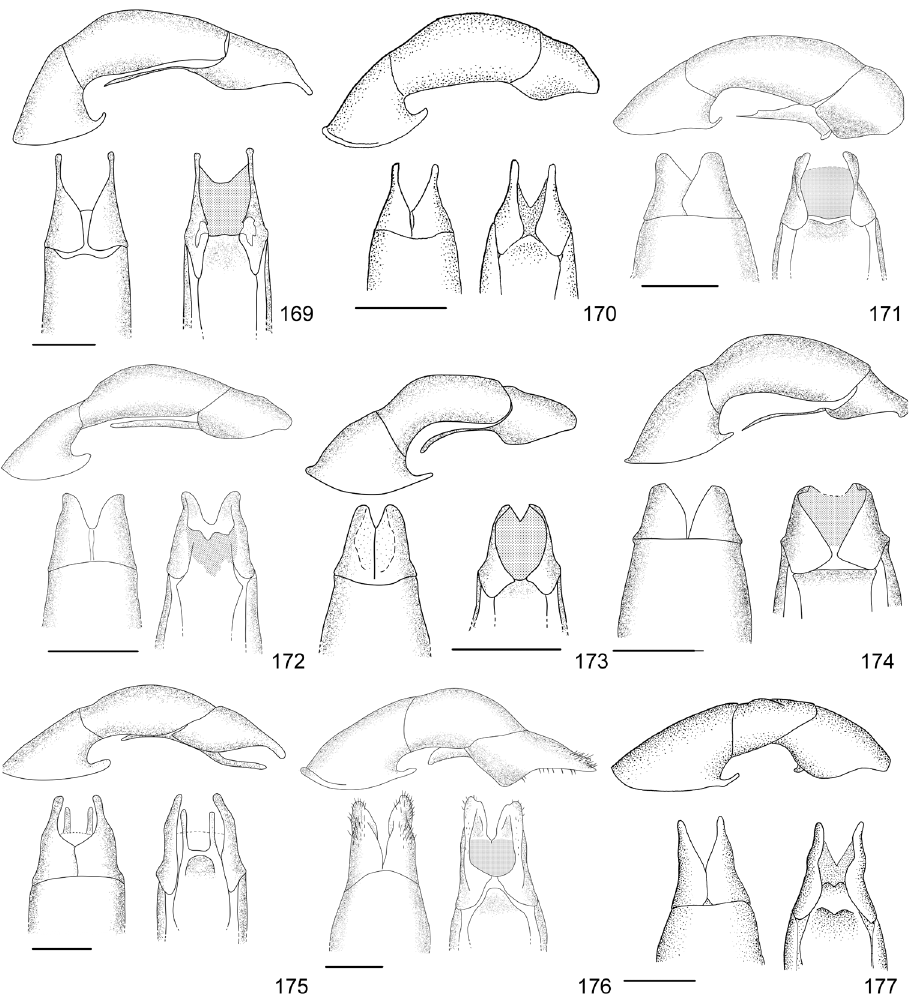
Figures 169–177. Shape of aedeagus, lateral view (top), dorsal view (bottom left), ventral view (bot- tom right). 169 Anomala praecellens (Orosilito, Guanacaste, CEUA) 170 A. pseudoeucoma (Estación Hi- toy Cerere, Limón, MNCR) 171 A. quiche (Estación Maritza, Guanacaste, MNCR) 172 A. robiginosa (Zarcero, Alajuela, MNCR) 173 A. ruatana (Playa Naranjo, Guanacaste, MNCR) 174 A. semicincta (Albergue Heliconias, Alajuela, CEUA) 175 A. semilla (Albergue Heliconias, Alajuela, CEUA) 176 A. solisi (Amubri, Limón, MNCR) 177 A. stillaticia (La Catarata, Cartago, MNCR). Scale bars: 1 mm. Fig. 170 from Filippini et al. (2013); Figs 174–176 modified from Filippini et al. (2014); Fig. 171 modified from Filippini et al. (2015b); Fig. 172 from Filippini et al. (2015c); Fig. 177 from Filippini et al.